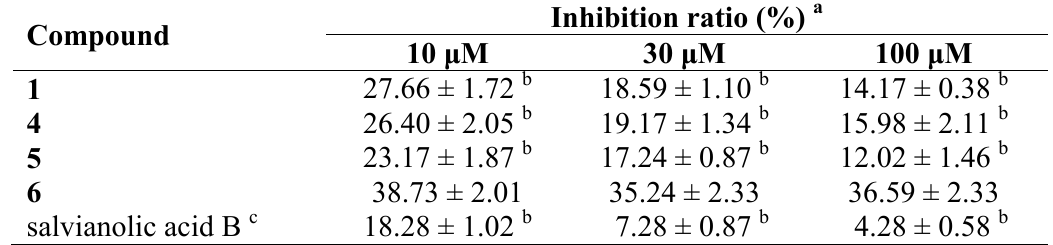
Table 1. Neuroprotective effects of the compounds 1 , 4 – 6 against the A β